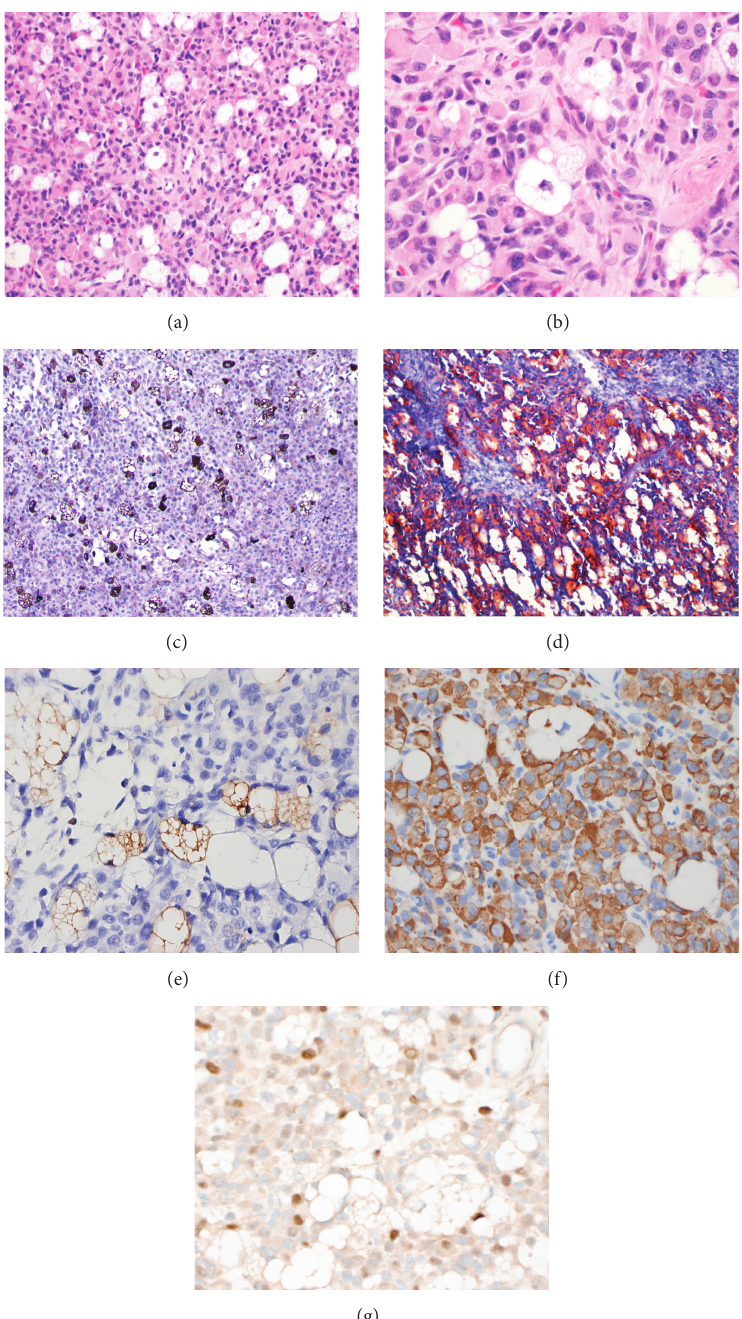
Figure 2: Histochemical and immunohistochemical studies in posttreatment rhabdomyosarcoma. (a) Microscopic appearance of resected tumorafteradjuvantchemotherapy,demonstratingdiffusesheetsofroundtumorcells(H&E, × 200originalmagnification)and(b)vacuolated adipocyte-like cells (H&E, × 400 original magnification). (c) Adipophilin demonstrates strong membrane staining within adipocyte-like cells (adipophilin immunostain, × 100 original magnification). (d) Oil Red O histochemical stain highlights intracytoplasmic lipid within the adipocyte-likecells(OilRedO, × 200originalmagnification).(e)Theadipocyte-likecellsstainwithS-100protein(S-100proteinimmunostain, × 400 original magnification). (f) A subset of vacuolated adipcoyte-like cells show focal cytoplasmic desmin positivity (desmin immunostain, × 400 original magnification) but myogenin (g) is negative in vacuolated cells, staining only the nuclei of rhabdomyoblasts (myogenin immunostain, × 400 original